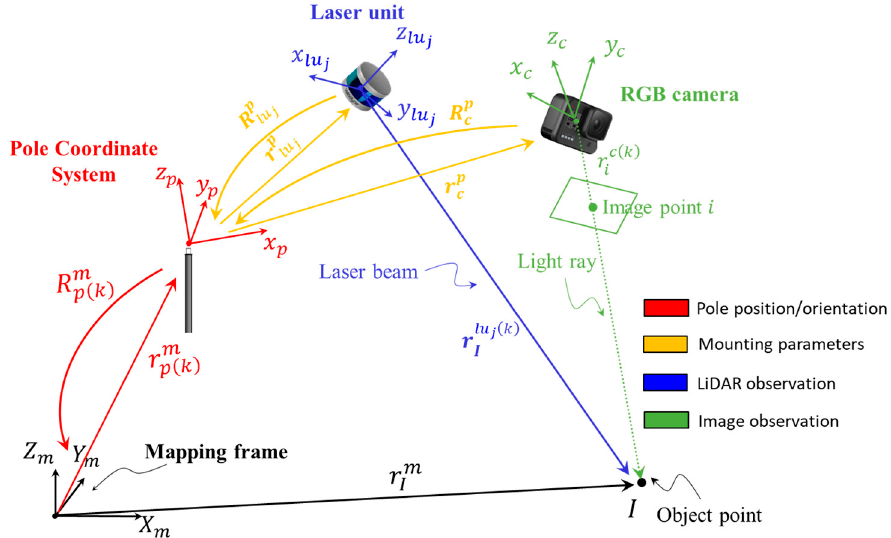
Figure 7. Schematic diagram illustrating the point positioning equations for 3D reconstruction using camera and LiDAR units mounted on the SMART system. For a better visualization of system parameters, the camera and LiDAR units are depicted much farther from the pole compared to their actual mounting positions.